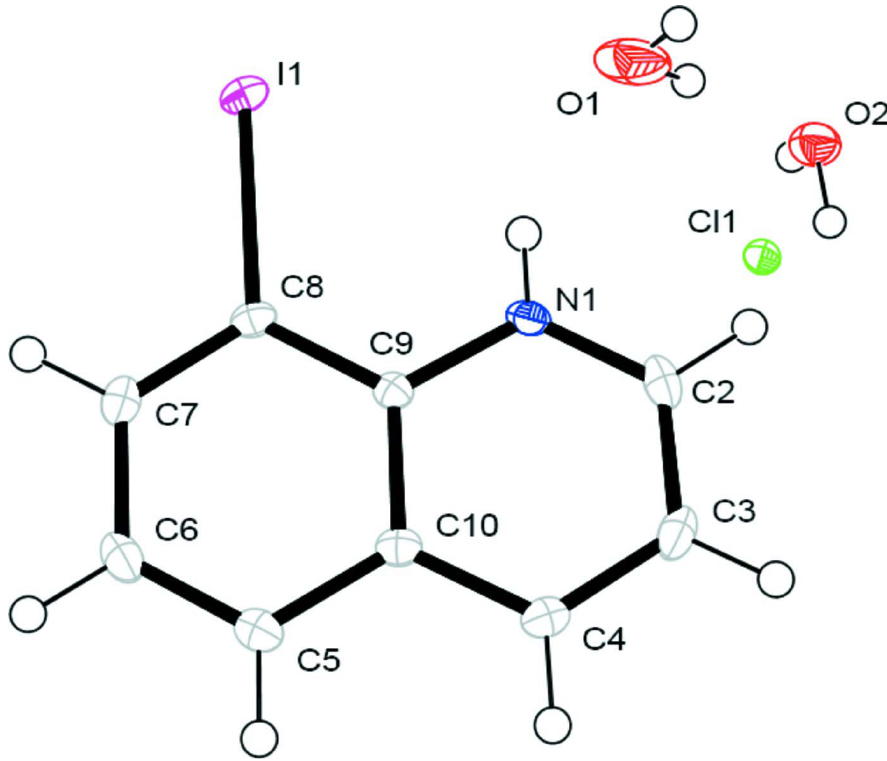
Asymmetric unit of 8-iodoquinolinium chloride dihydrate. Displacement ellipsoids are drawn at the 50% probability